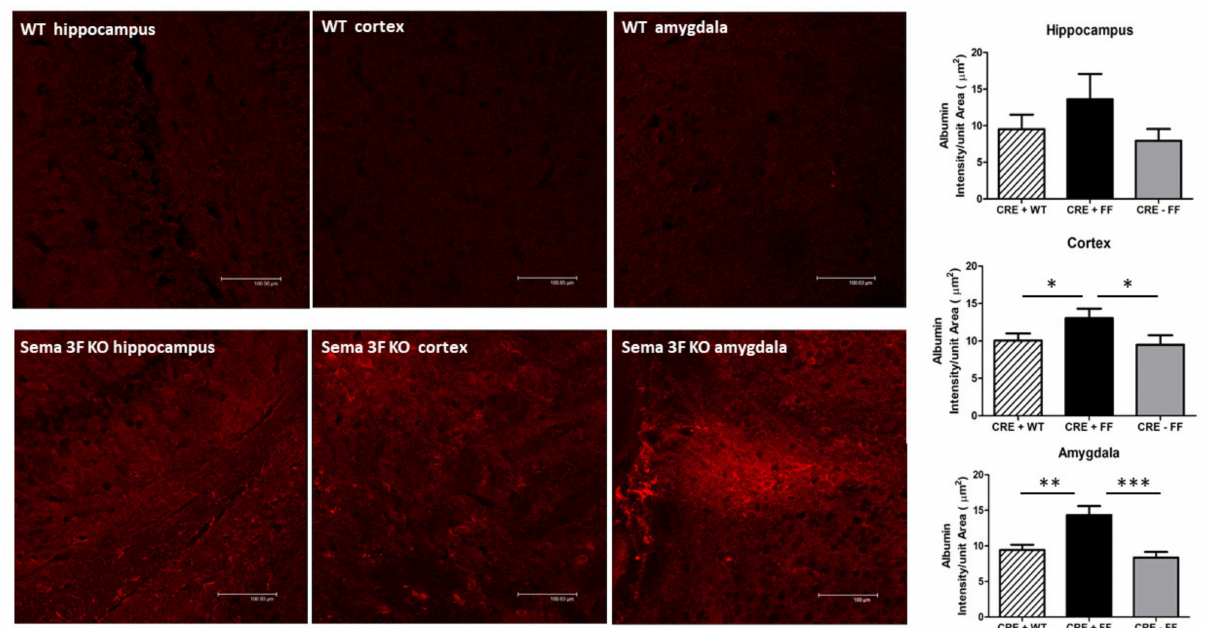
Figure 12. Vascular Leakage of Albumin in Sema 3F KO Mice . Left panel: Albumin immunofluo- rescence in hippocampus, cortex, and amygdala of perfused Sema 3F KO mice and their wild type (WT) littermate. While perfusion removed most of the vascular albumin from WT tissue, significant albumin remained in the tissue of Sema 3F KO mice, suggesting vascular leakage. Right panel: quantification of albumin immunofluorescence showed significantly higher fluorescence/unit area in the hippocampus, cortex, and amygdala of Sema 3F KO mice compared to the two control mice, which did not reach significance in the hippocampus. *** p ≤ 0.0001; ** p ≤ 0.001; * p ≤ 0.01; n =